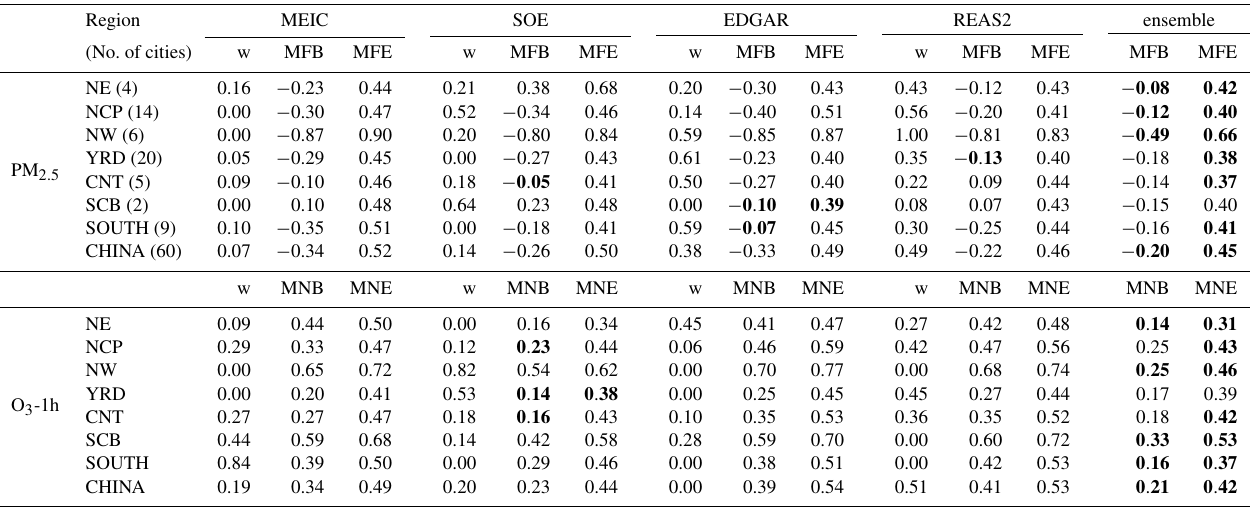
Table 3. Performance of daily PM 2 . 5 (MFB and MFE) and O 3 -1h (MNB and MNE) in different regions of China based on individual inventories and the ensemble. The weighting factors ( w ) used to calculate the ensemble of each region are also included. The best performance is indicated by the bold numbers.